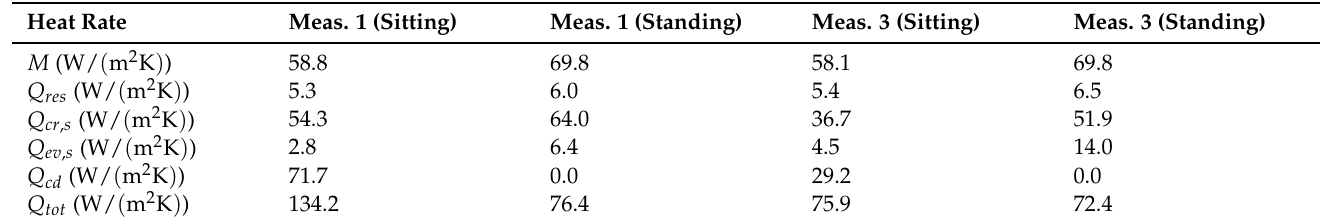
Table A2. Average metabolic rates of heat production and rates of heat loss for Meas. 1 and Meas. 3 and both sitting and standing positions.